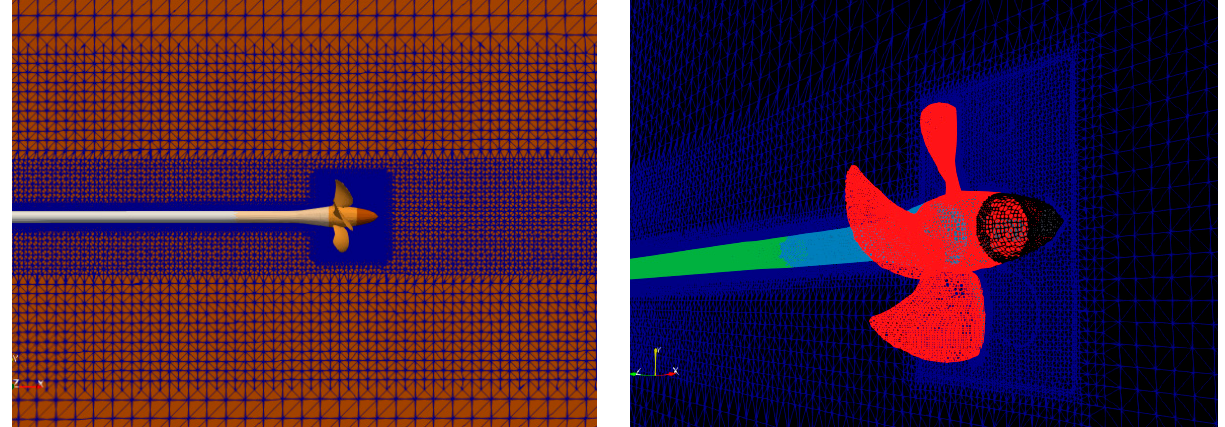
Figure 2. Mesh generated structure around the propeller. Table 3. Primary data assumed in calculations.